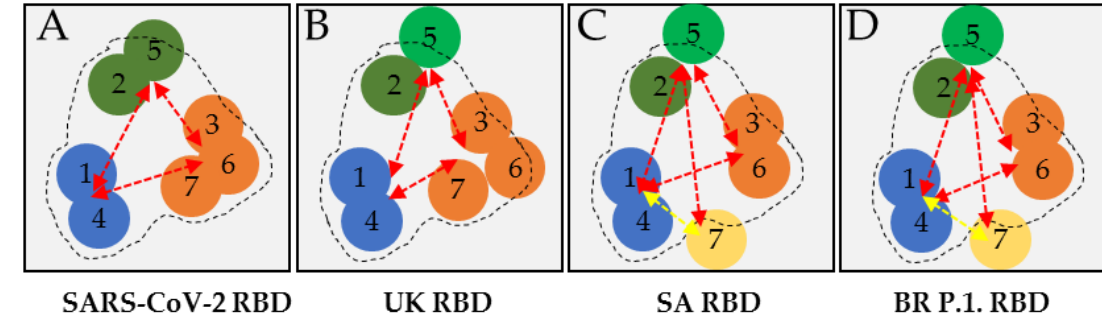
Figure 7. Functional arrangement map of the antibody pairing capability and neutralizing activity. ( A – D ) Reactivity arrangement map of seven monoclonal antibodies to SARS-CoV-2 RBD, UK RBD, SA RBD, and BR P.1 RBD, respectively. (Note 1) Blue circle: epitope bin A antibodies (Ab1 and Ab4). Green circle: epitope bin B antibodies (Ab2 and Ab5). Orange circle: Epitope bin C antibodies (Ab3, Ab6, and Ab7). (Note 2) A red, double-headed arrow indicates antibody pairing with strong detection capability. A yellow, double-headed arrow indicates antibody pairing with weakened detection capability. (Note 3) A black dotted line indicates the neutralization functionality; inside the dotted line represents strong neutralization activity, and being on or outside the dotted line represents weak or no neutralization activity.